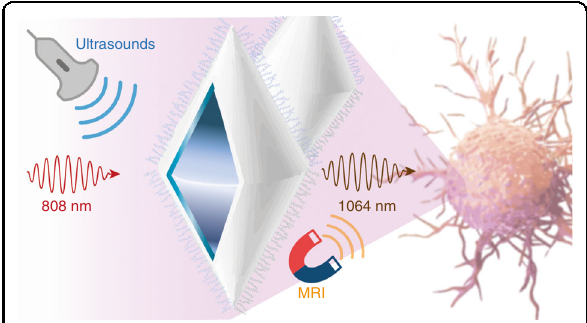
Fig. 1 Schematic illustration of the bimodal core-shell nanostructures designed by Lv et al. 14 to overpass the BBB and target orthotopic gliomas. NIR-II and MRI are induced by simultaneous ultrasound and 808 nm